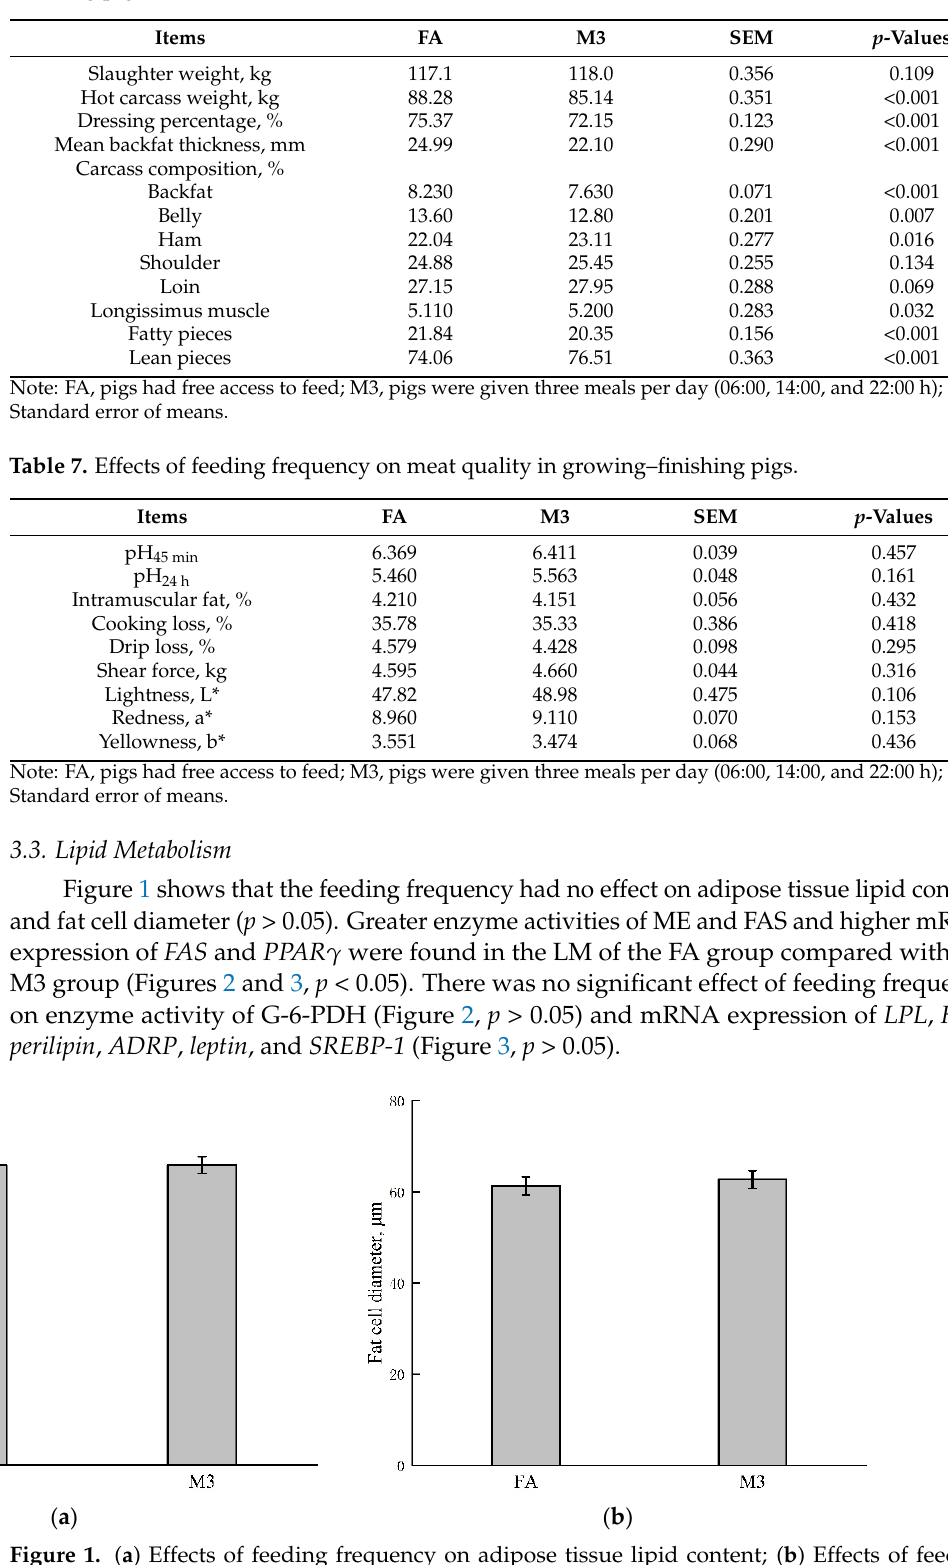
Table 6. Effects of feeding frequency on carcass quality and carcass composition in growing– finishing pigs.